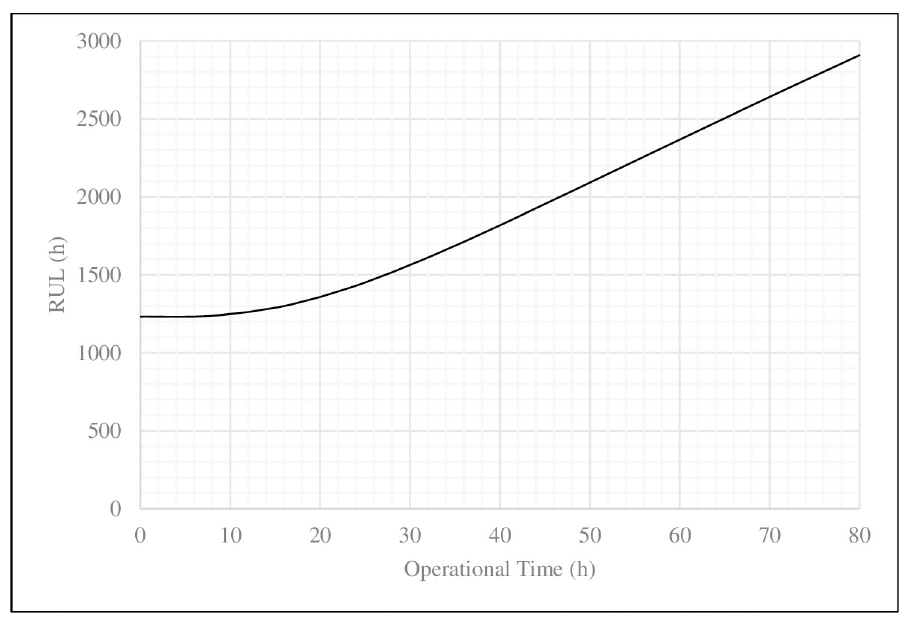
Fig 6. The plot of RUL values during 80 operational hours of the excavator in the Weibull-frailty model.